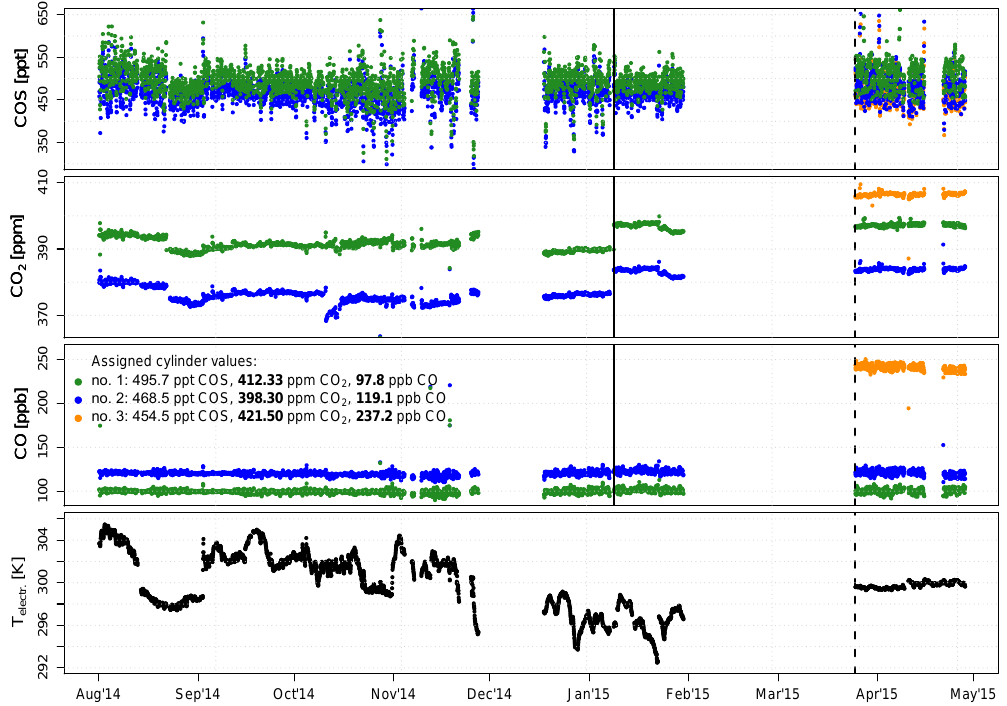
Figure 5. Mean concentrations of hourly measurements of working standards conducted while the instrument was in the field from August 2014 until April 2015 together with electronics temperature. The data shown here are uncorrected data and are not calibrated with a response curve. The concentrations are therefore not necessarily close to the assigned cylinder values. The solid vertical line at 7 January 2015 indicates the moment when we changed the setup with a solenoid valve to a Valco valve for switching to nitrogen, as the solenoid valve was leaking. The dashed vertical line at 25 March 2015 indicates the moment when we improved the temperature stability by actively cooling the electronics section and putting the analyzer in an enclosed box, which resulted in substantially smaller temperature fluctuations than before. From this moment onwards an extra working standard was also measured every hour to ascertain if the instrument response was stable over a period of 35 days (orange). The gap in the data record in December 2014 and February–March 2015 is because of tests with the QCLS in the